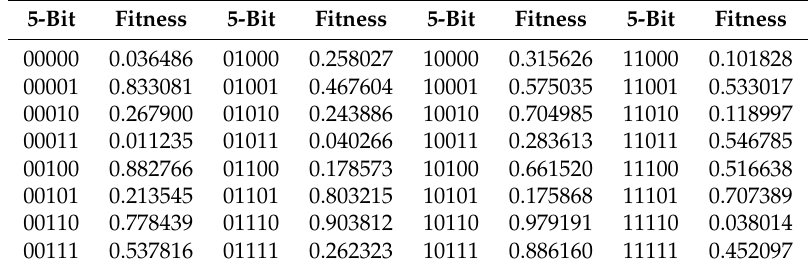
Figure 6. The fitness value of g in the sequential five bits, ( g r 1 , g r 2 , g , g (cid:96) 1 , g (cid:96) 2 ), in NKL-K4. Table 1. The fitness of g in the sequential five bits, ( g r 1 , g r 2 , g , g (cid:96) 1 , g (cid:96) 2 ), in NKL-K4. The five-bit string in the table represents ( g , g r 1 , g r 2 , g (cid:96) 1 , g (cid:96) 2